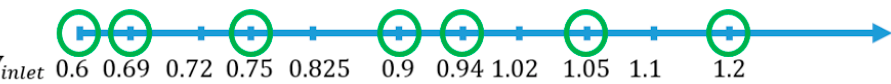
Figure 26. All inlet air velocities used in MFIX simulations along with inlet velocities used in ANN training.